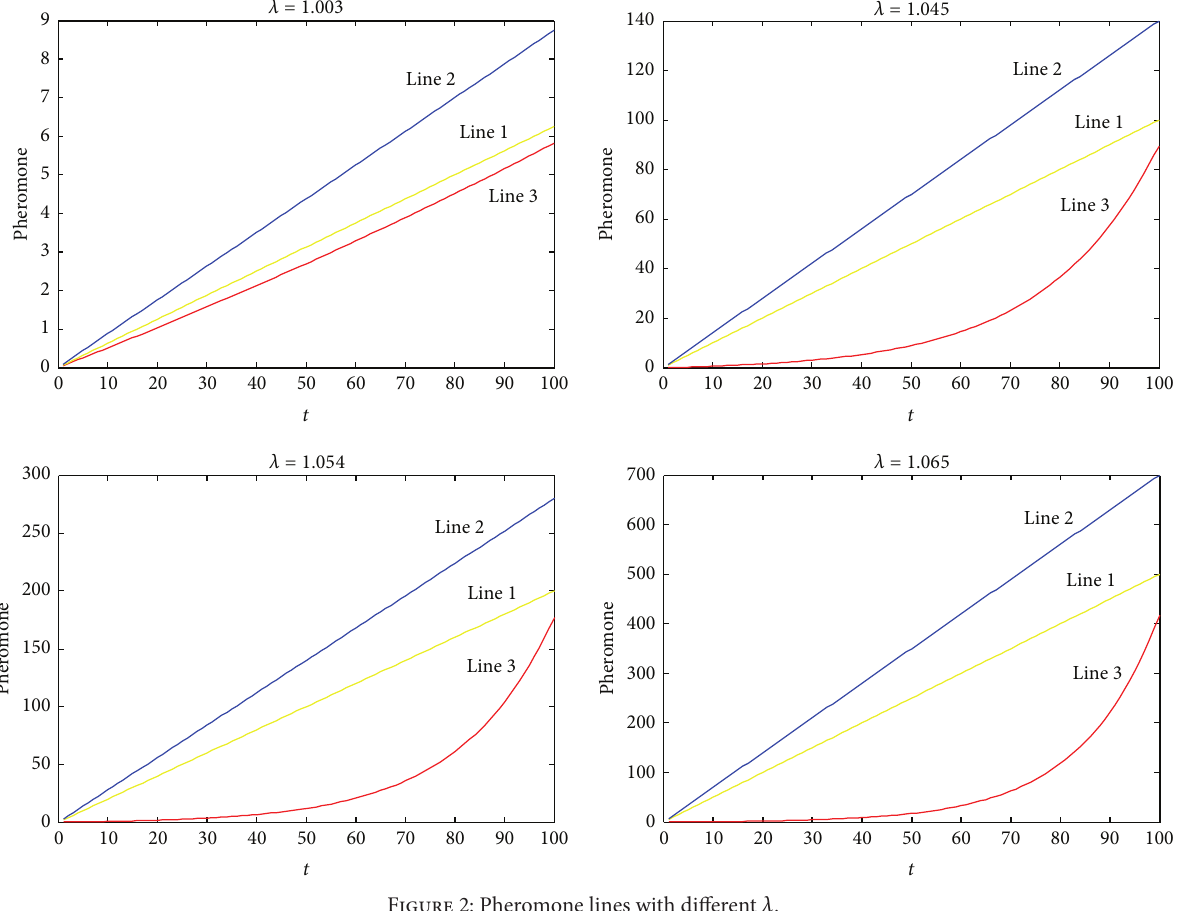
Figure 2: Pheromone lines with different 𝜆 .